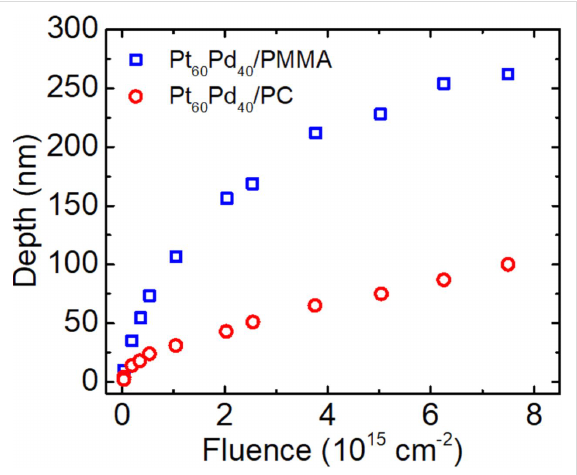
Figure 6: Fluence dependence of the irradiation-induced depth for the Pt 60 Pd 40 /PC sample (red circles). For comparison, the fluence depen- dence for a 15 nm Pt 60 Pd 40 /770 nm PMMA sample (blue squares) measured in our previous study [4] is also presented. The samples were irradiated with a 25 keV He + FIB within a fluence range from 4.0 × 10 13 to 7.5 × 10 15 cm − 2